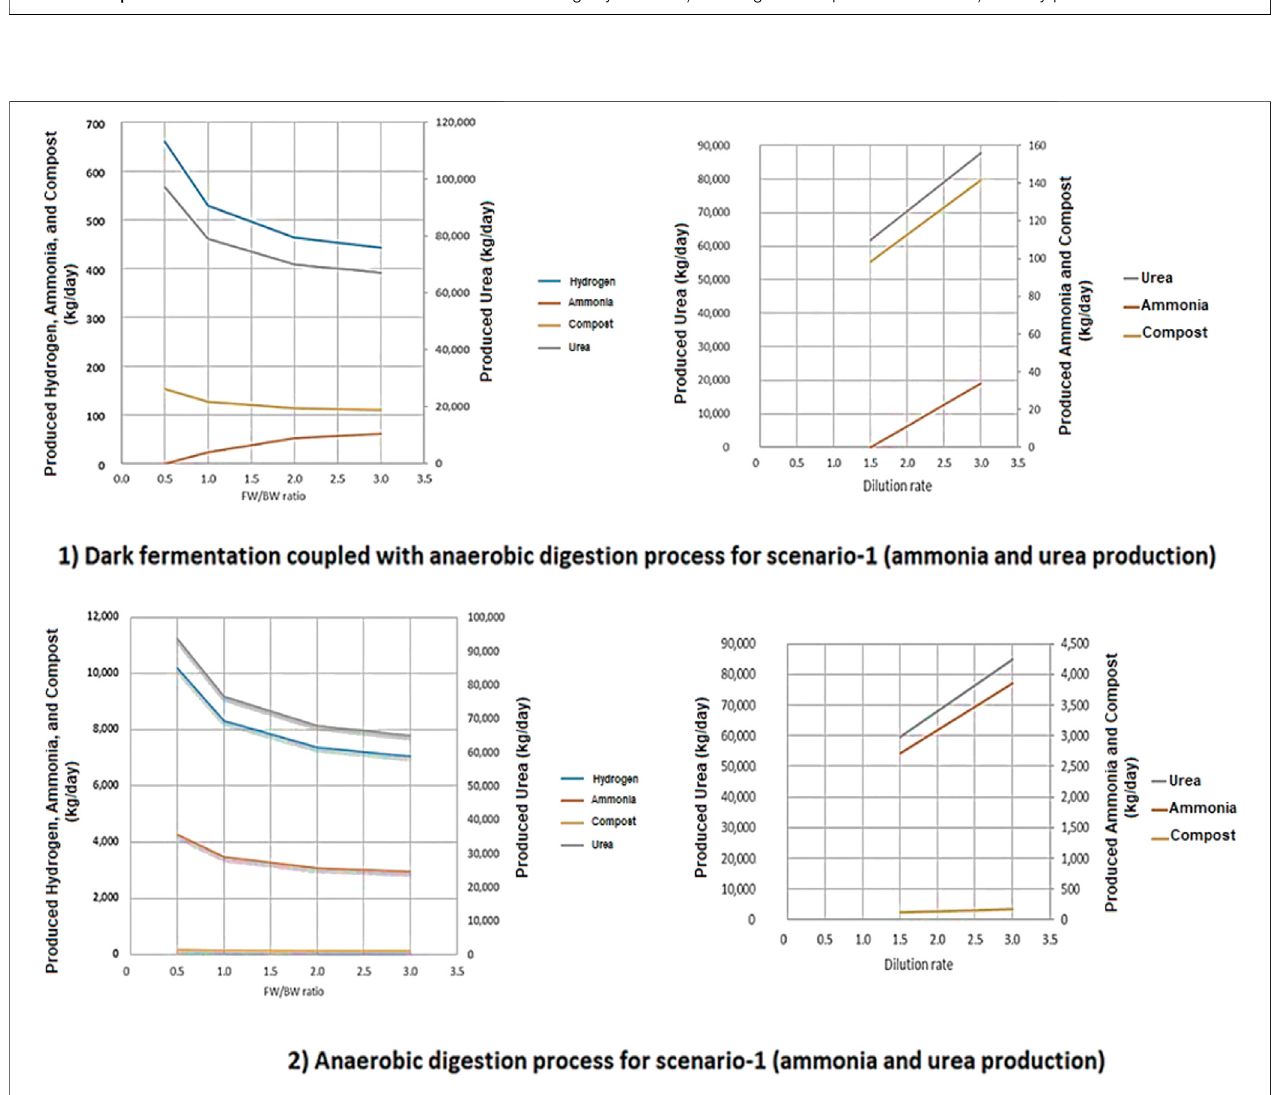
FIGURE12 | TheeffectofFW/BWratioanddilutionrateonproducedhydrogen,ammonia,urea,andcompostforboth1)twostageDFcoupledwithADand2)AD-onlyprocess.